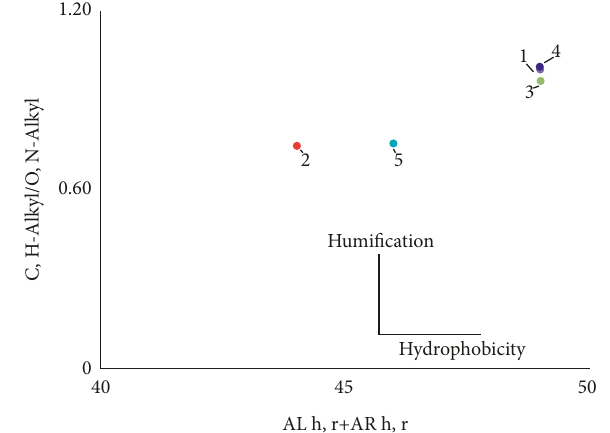
Figure 4: The diagram of integrated indicators of the molecular composition of HAs.